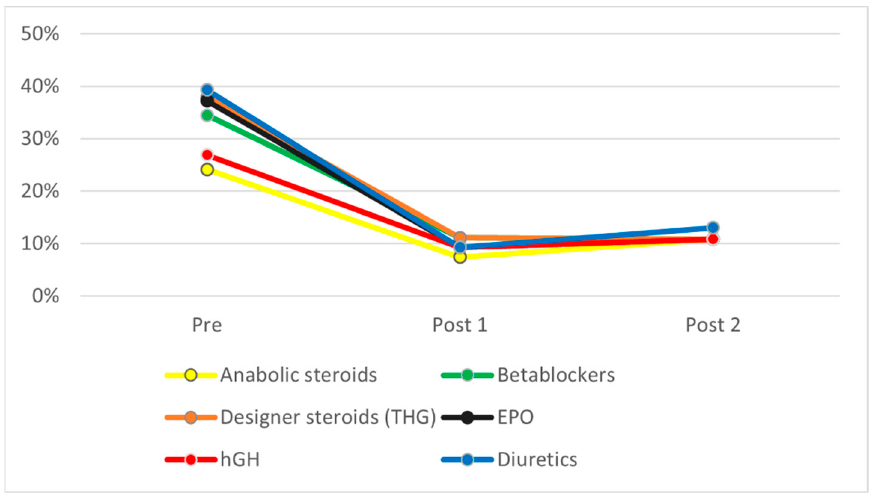
Figure 2. General ignorance about PES use on health in the short ‐ term.